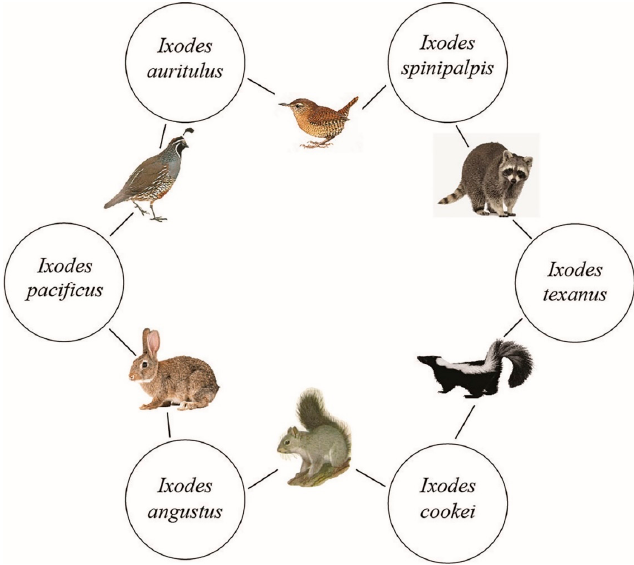
Figure 4. A 6-tick cycle of Borrelia burgdorferi sensu lato on Vancouver Island, B.C. Collectively, these six tick species form an interconnecting link between multiple hosts in a multipart enzootic maintenance cycle of Bbsl. Five of these tick species bite humans.